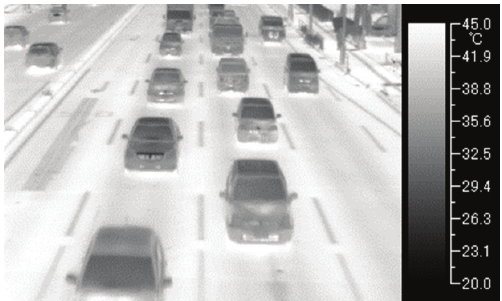
Figure 2: A frame of obtained thermal images.